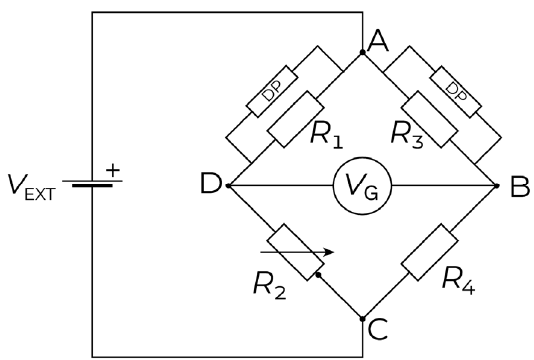
Figure 2. Wheatstone bridge with digital potentiometers.